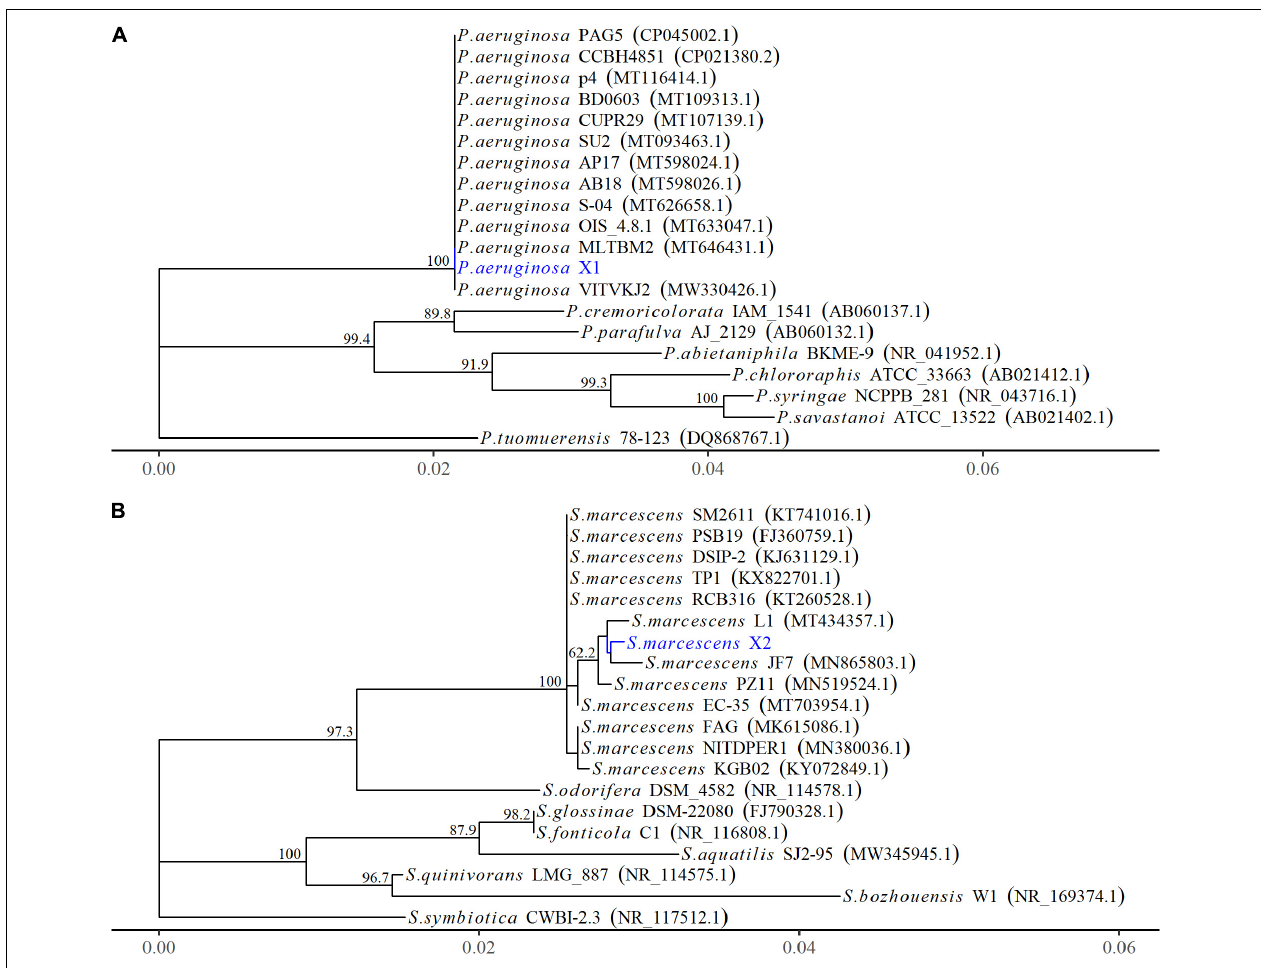
FIGURE 2 | The phylogenetic relationships of Pseudomonas aeruginosa and Serratia marcescens strains based on 16S rRNA gene. (A) The phylogenetic tree of Pseudomonas aeruginosa X1. (B) The phylogenetic tree of Serratia marcescens X2.The Phylogenetic tree was constructed using MEGA-X based on the maximum likelihood method, using the Kimura 2-parameter model. All bootstrap values > 50 from 1,000 replications are shown on the interior branch nodes. The sequences obtained in this study are in blue. GenBank accession number is provided next to the tick species